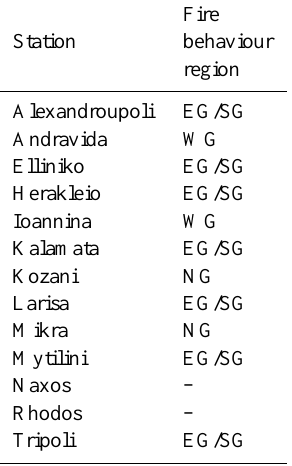
Table 2. Classification of the meteorological stations according to their fire risk